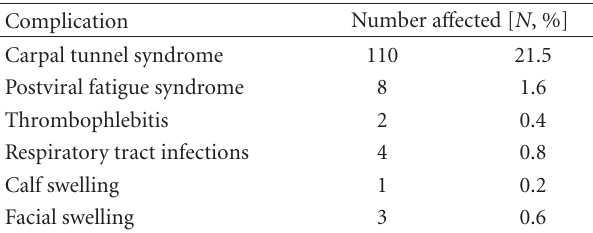
Table 4: Nonarthritic complications among chikungunya-a ff ected patients.